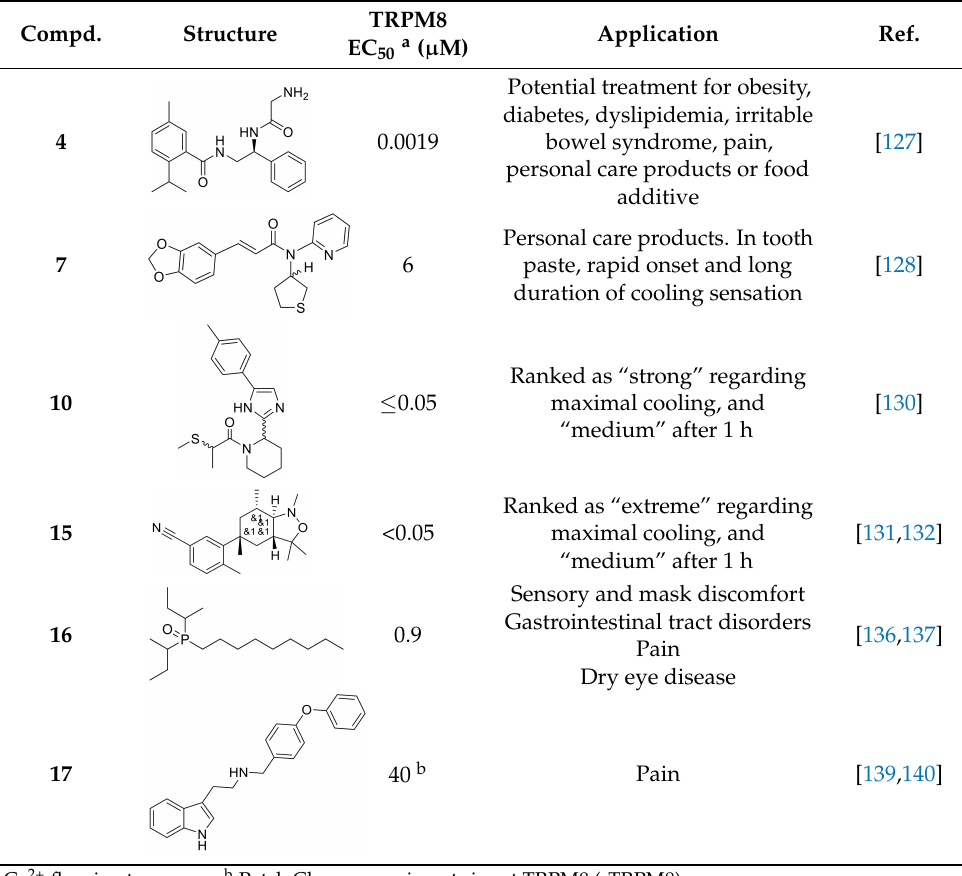
Table 1. Selected examples of newly described families of TRPM8